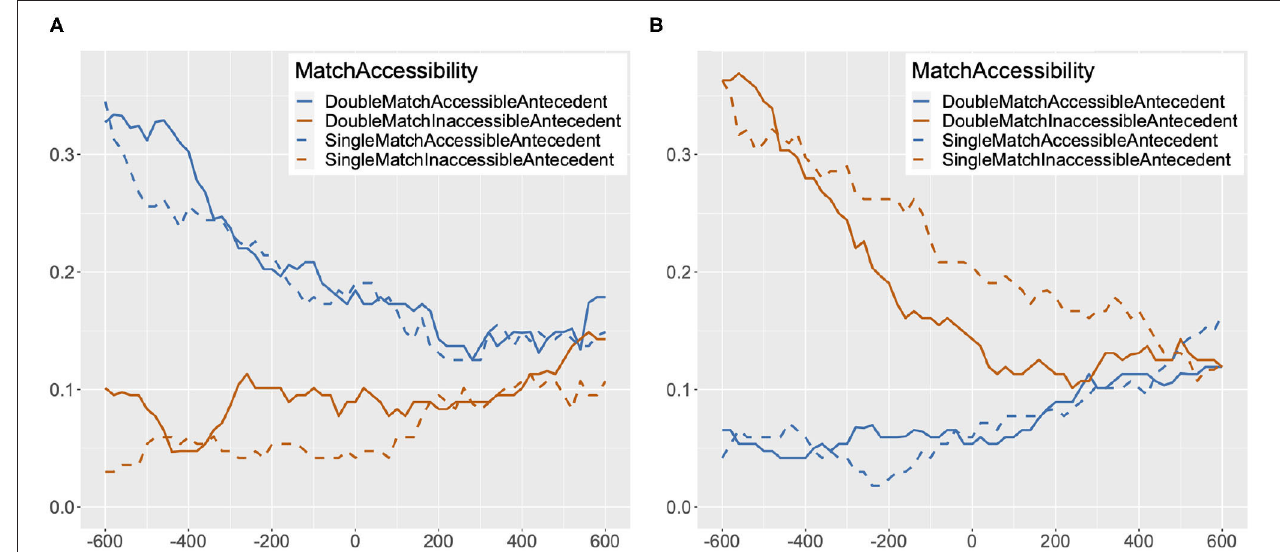
FIGURE 5 | Proportion of looks to accessible/inaccessible antecedent image in double/single match condition at every 20 ms from 600 ms before the onset of the target anaphor to 600 ms after the onset, Experiment 2. (A) Proportion of Looks: Reflexive. (B) Proportion of Looks: